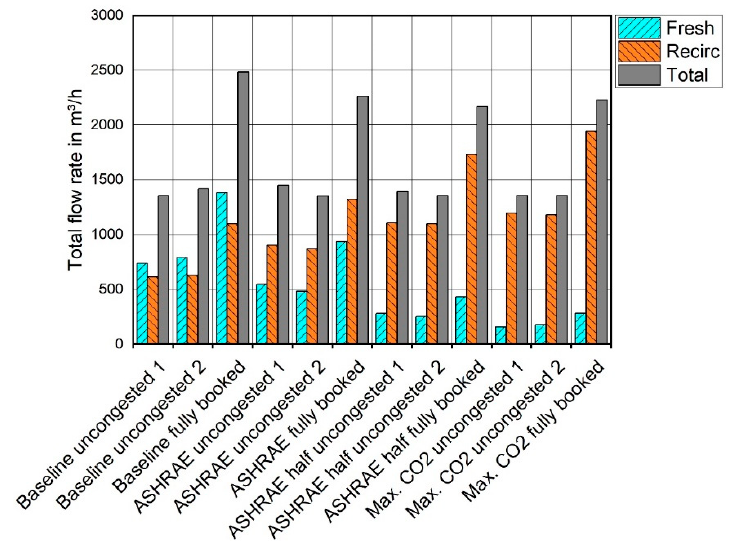
Figure 7. Total airflow rates in the cabin.